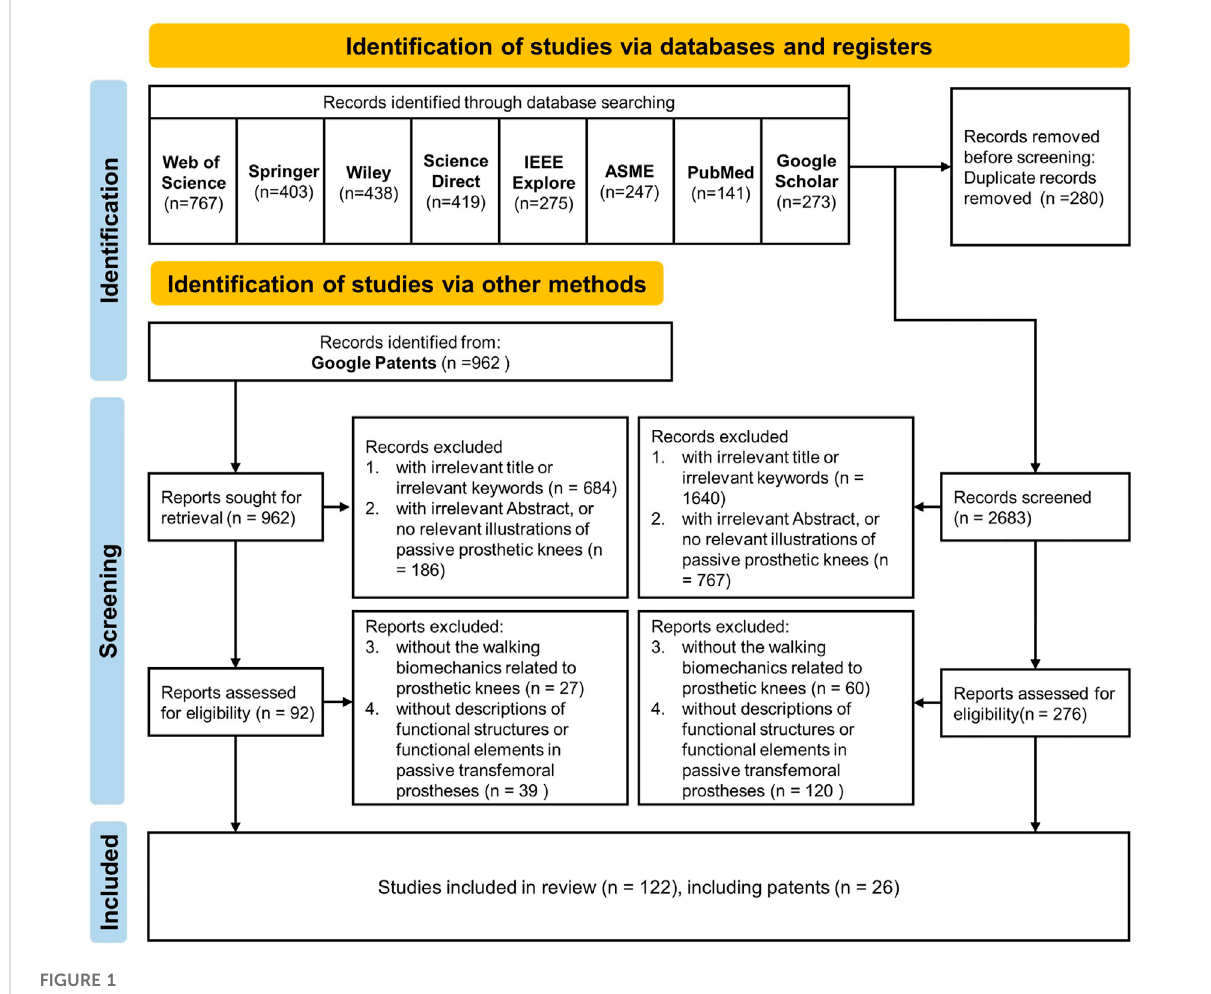
FIGURE 1 Flowchart of database search and manual search based on